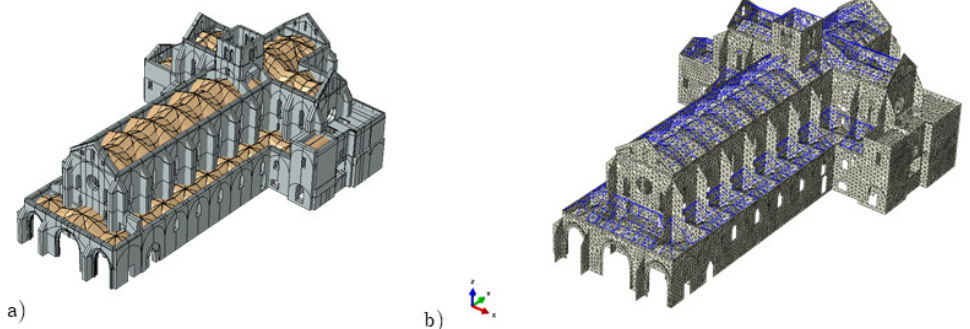
Figure 5. Three-dimensional model of the church: ( a ) geometrical model and ( b ) finite element